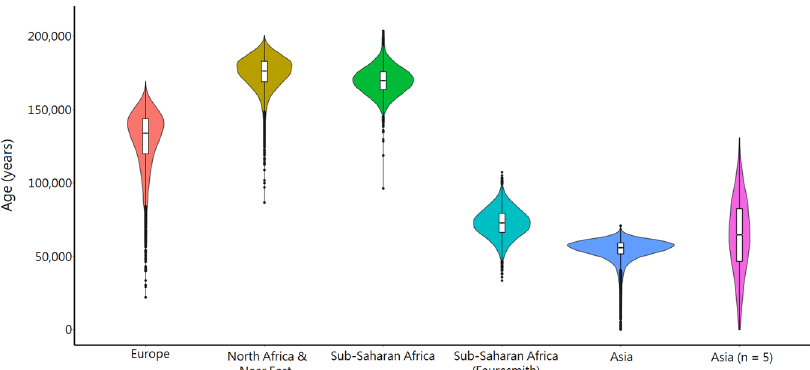
Fig. 3 Violin-boxplots detailing predicted dates for the end of the Acheulean in Europe, Asia, Sub-Saharan Africa, and North Africa and the Near East. A Sub-Saharan African model including Fauresmith sites is also displayed, as is the modi fi ed Asian ( n = 5) model. Data are derived from 10,000 iterations of the random sampling method. Negative outliers in the Asian models extended beyond ‘ 0 ’ , and are not visible.